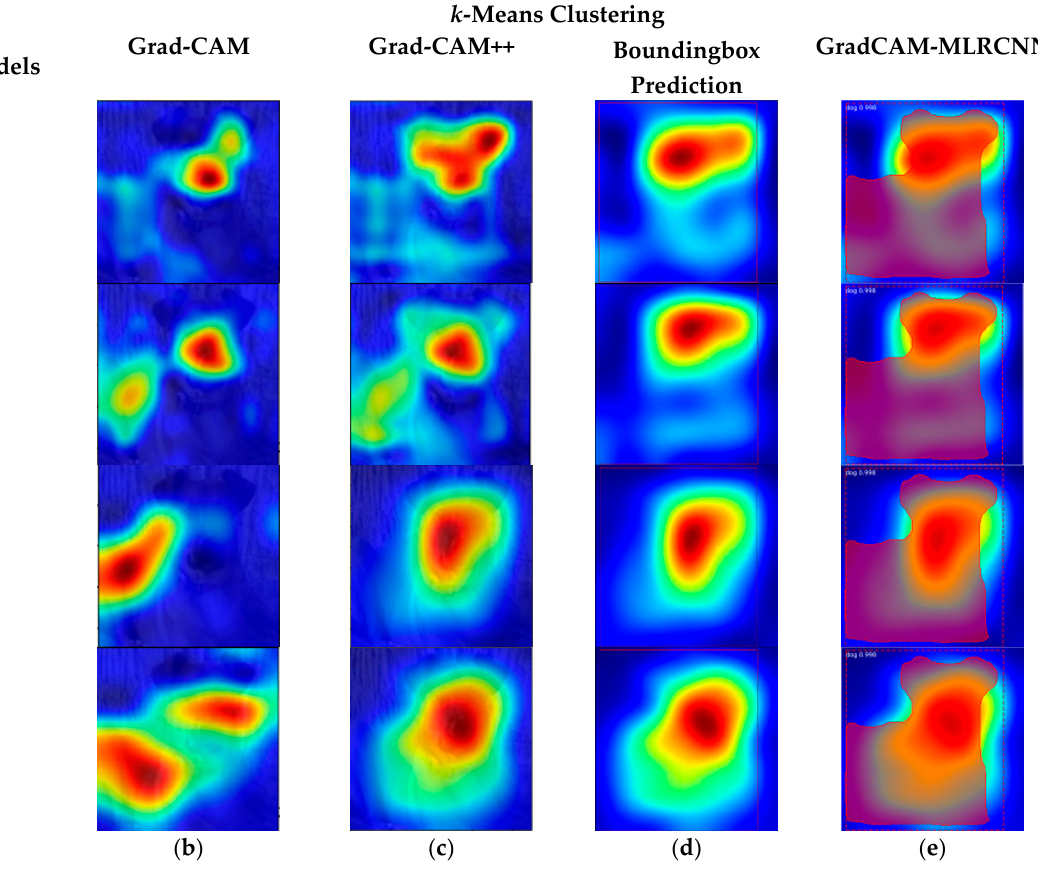
Figure 11. ( a ) Various pre-trained models; ( b ) results of Grad-CAM; ( c ) results of Grad-CAM++; ( d ) bounding box prediction on Grad-CAM++; and ( e ) GradCAM-MLRCNN. As demonstrated in Figures 3, 5, 7, 9, and 11, the framework generated the bounding boxes with segmented masks for each class in an image. To avoid overfitting the model and improve its performance, the transfer learning from the pre-trained model (VGG 16, VGG 19, ResNet 101, and ResNet 152) on the MS-COCO dataset was used. Initially, we used ResNet 152 as a feature extractor. This research work used Mask R-CNN and fine-tuned the parameters to match the pre-trained model to the Grad-CAM++.The input frames were scaled to 224 × 224 and have three channels (R, G, and B). The model is optimized using the stochastic gradient descent (SGD) technique with an initial learning rate of 0.00001 to discover the best weights to reduce the error between the expected and desired output. Momentum is a technique for reducing weight variation swings in continuous iterations that work on weighting after the weight has been changed. The proposed model run with 50 epochs to train and validate the data and then the loss is computed for every epoch while the learning processes. The confusion matrix on the testing dataset is provided in Table 7 to analyze the efficacy of the proposed method to prove the goodness of fit by chi-square statistical test. As displayed in the confusion matrix, the values in the first row, from left to right, reflect the True-Positive (TP) percent of properly identifying shadow and False-Positive (FP) percent of misclassifying shadow as object. The second row shows the False-Negative percentage (FN) of misclassifying an object as a shadow and the True-Negative percentage (TN) of accurately detecting an object. Three additional measures, namely